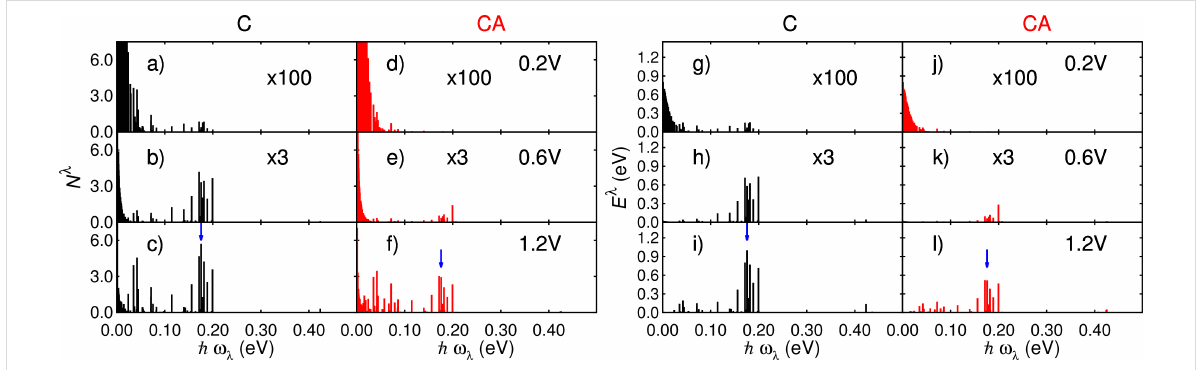
Figure 4: a–f) Populations of all vibrational modes at 0.2, 0.6 and 1.2 V for the junction with (CA) and without (C) the NH 2 adsorbate. g–l) Average energy of all modes for the two structures considered at 0.2, 0.6 and 1.2 V. Blue arrows indicate the mode at 175 meV studied in detail in the text.